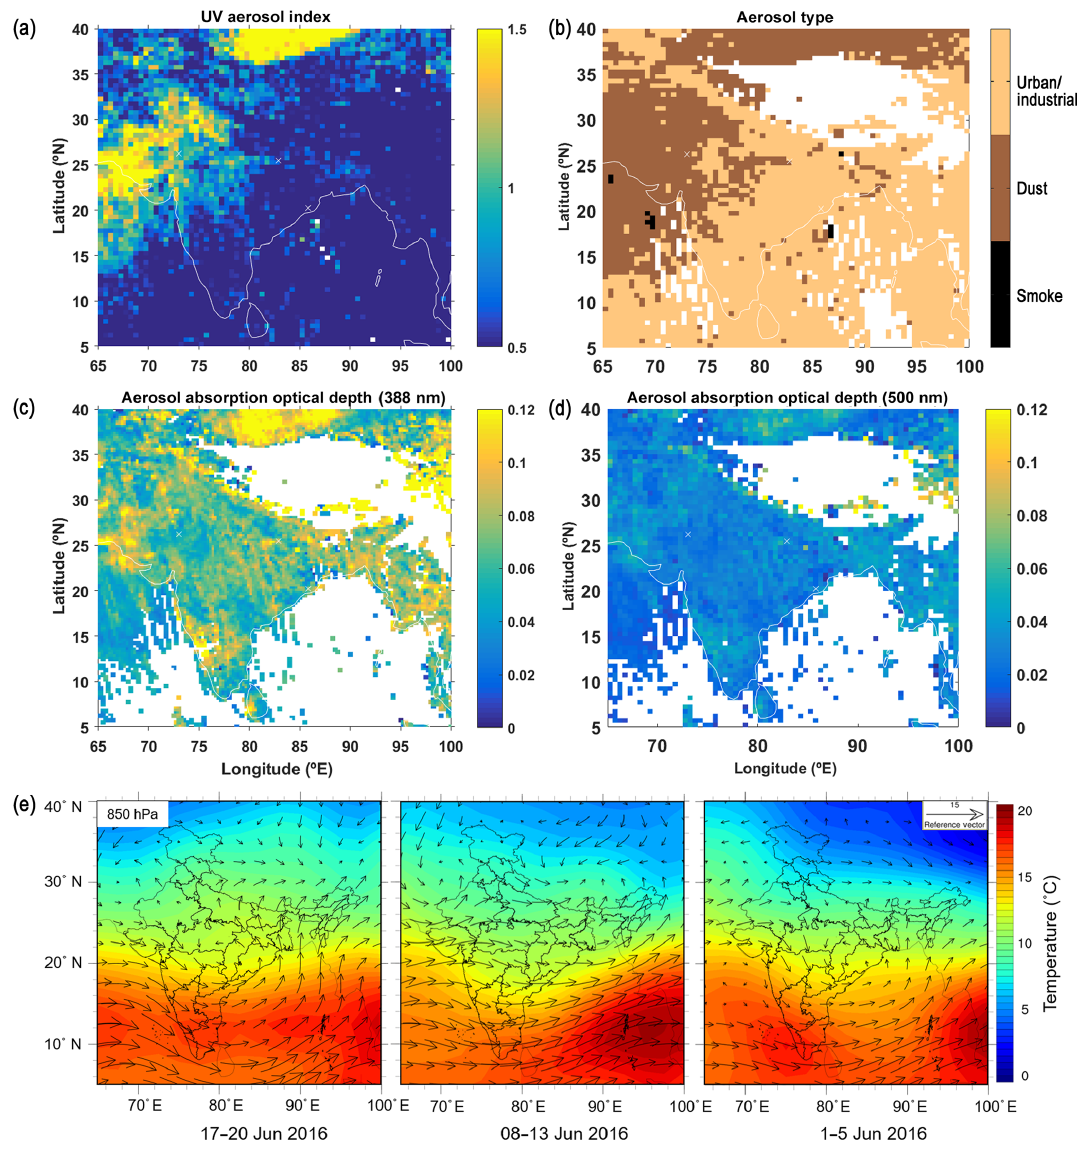
Figure 7. Spatial distribution of (a) UV aerosol index, (b) aerosol type, (c) aerosol absorption optical depth (AAOD) at 388nm and (d) AAOD at 500nm during June 2016. (e) Synoptic wind and temperature at